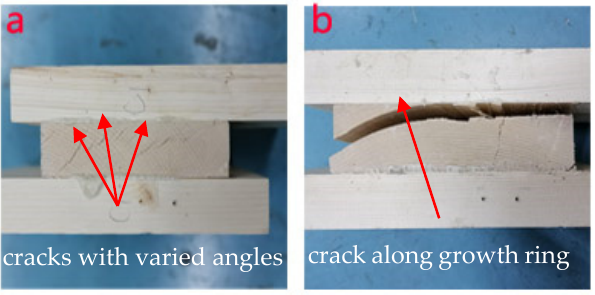
Figure 5. Failure modes of larger aspect ratio specimens: ( a ) II-45, ( b ) III-0.